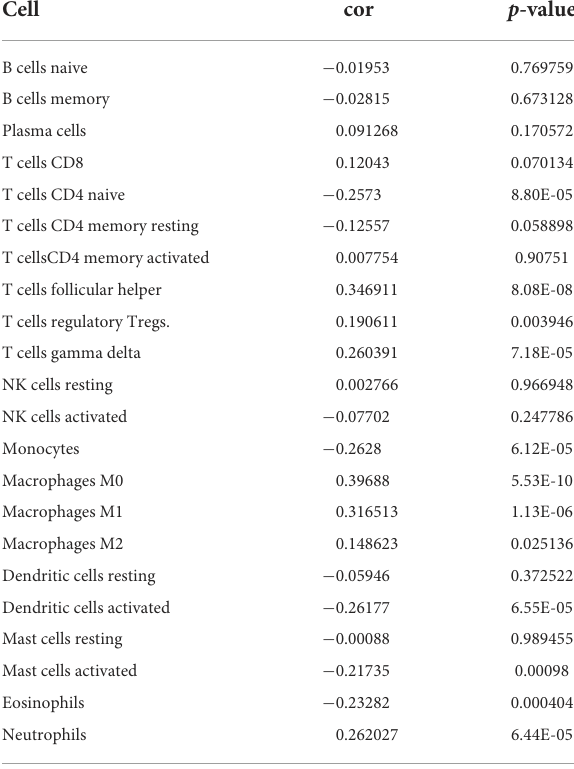
TABLE 1 Analysis of the correlation between CENPA and immune-infiltrating